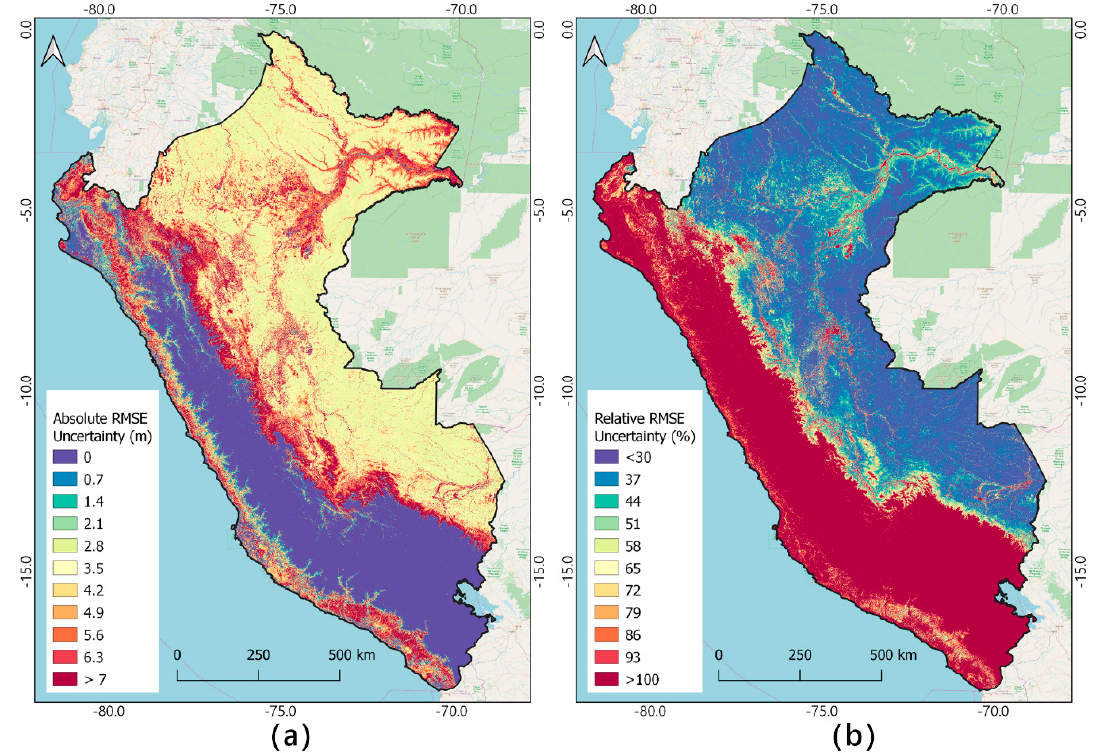
Figure 8. (a) Absolute RMSE uncertainty (in m) and (b) the relative RMSE uncertainty (% of estimated TCH).